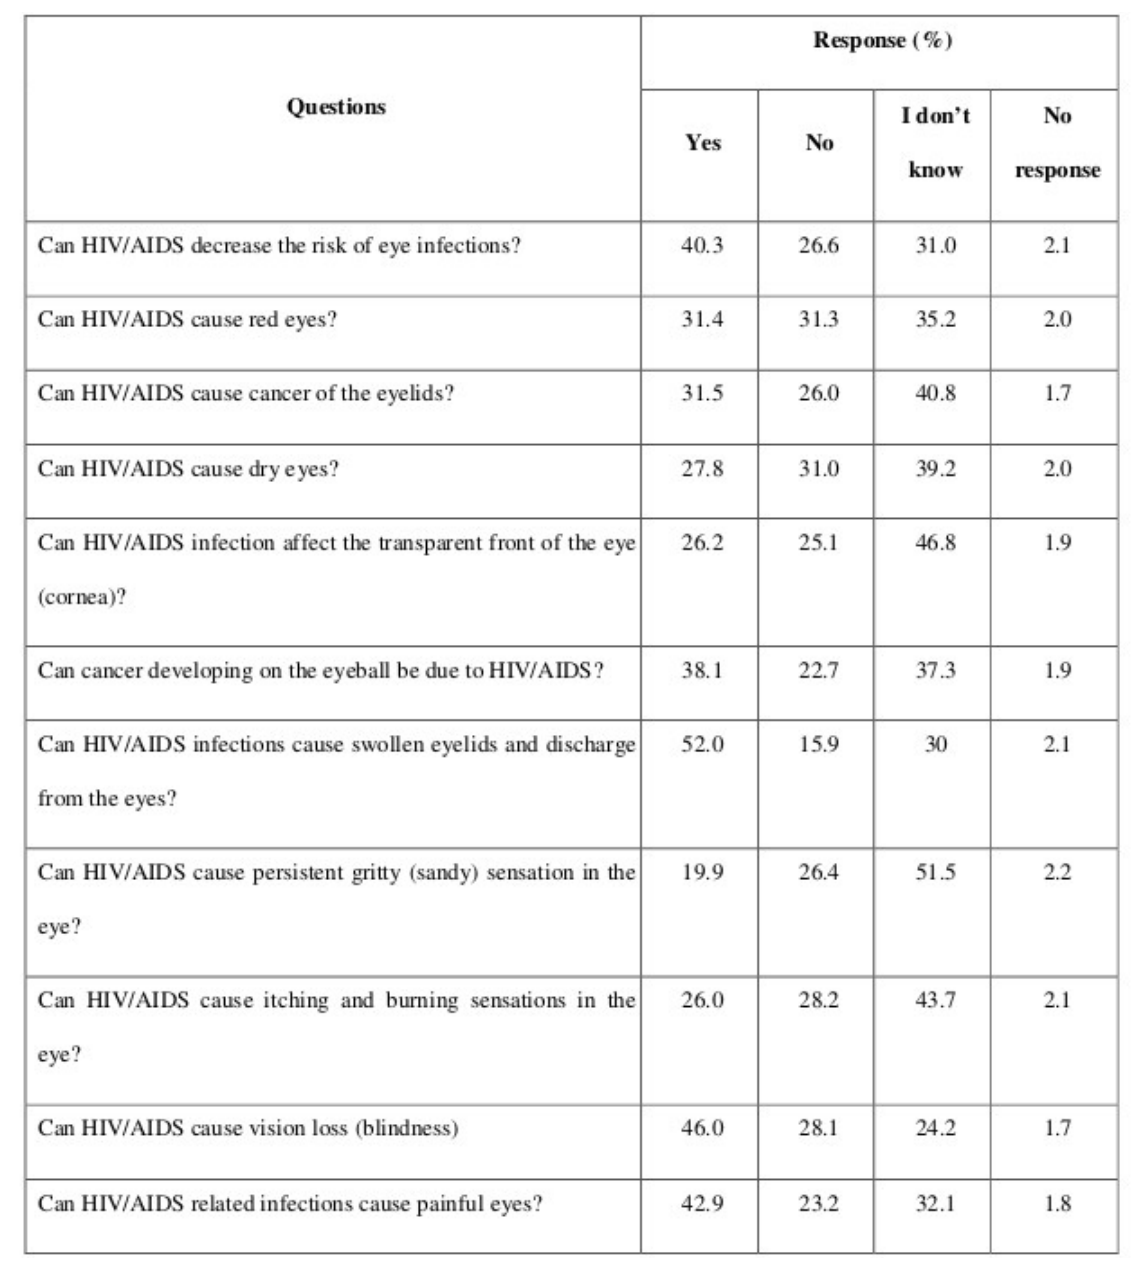
Table 1 : Listed questions and the responses of the